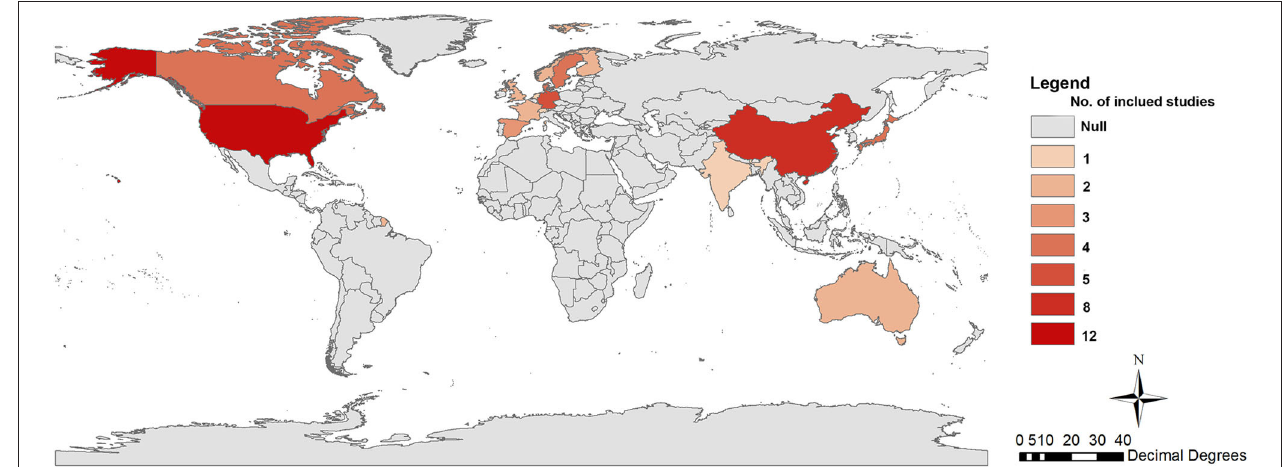
FIGURE 2 | Geographic distribution of included